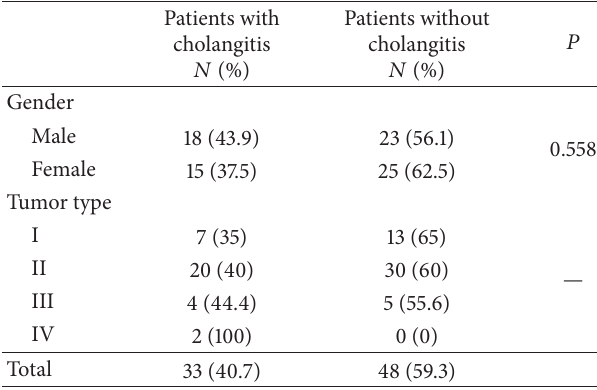
Table 3: Distribution of patients with respect to gender and tumor type by cholangitis